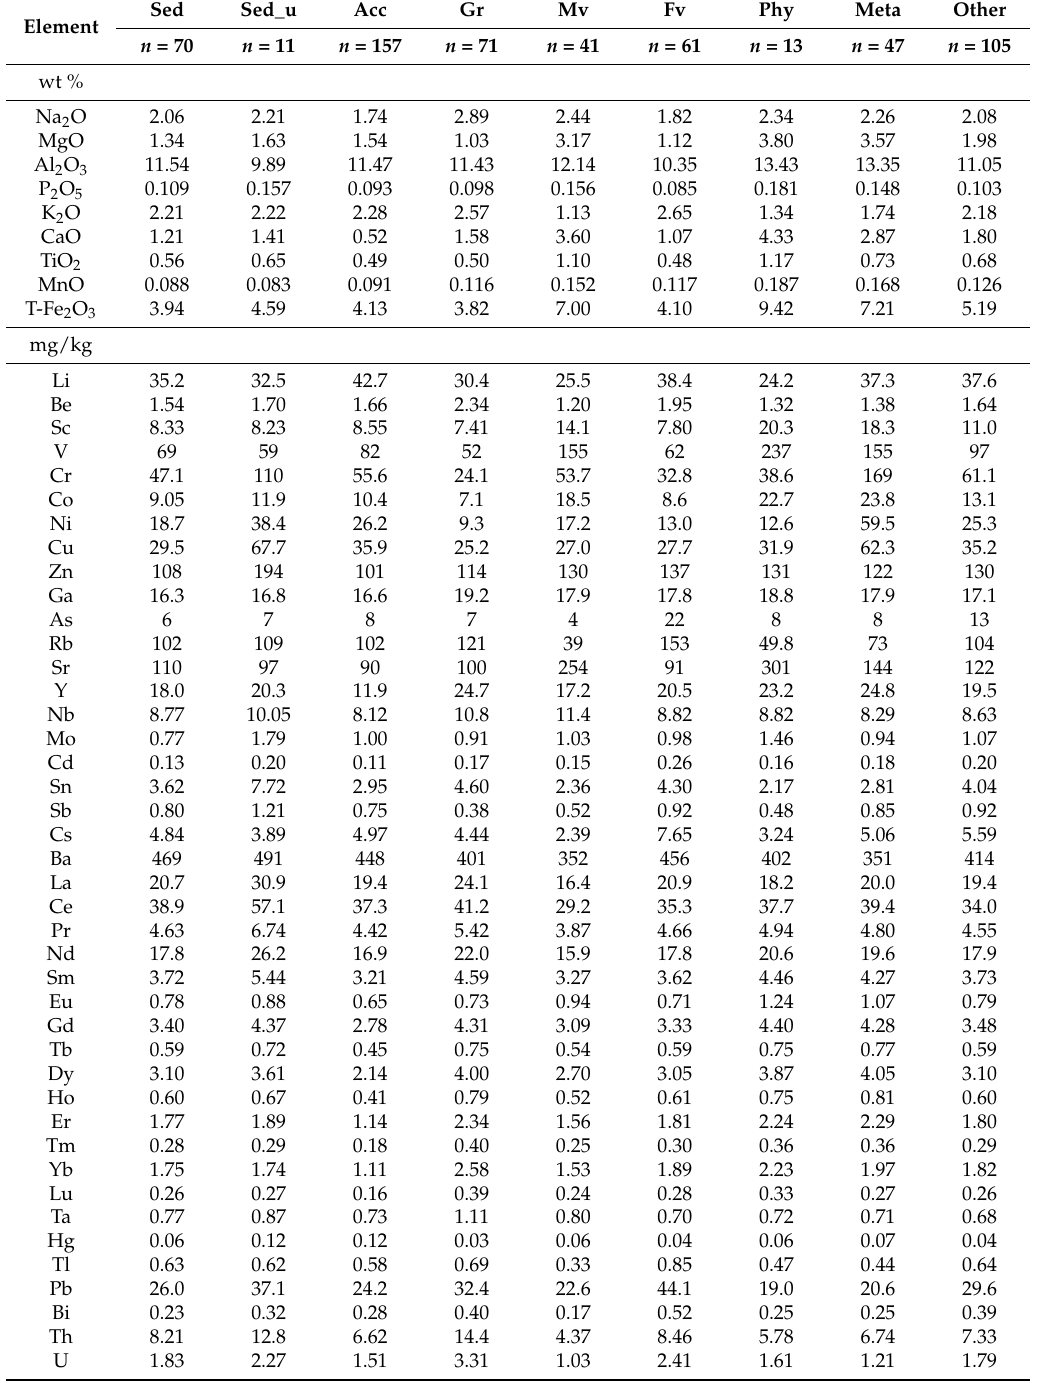
Table B1. Median elemental concentrations in stream sediments classified according to the dominant rock type in the drainage